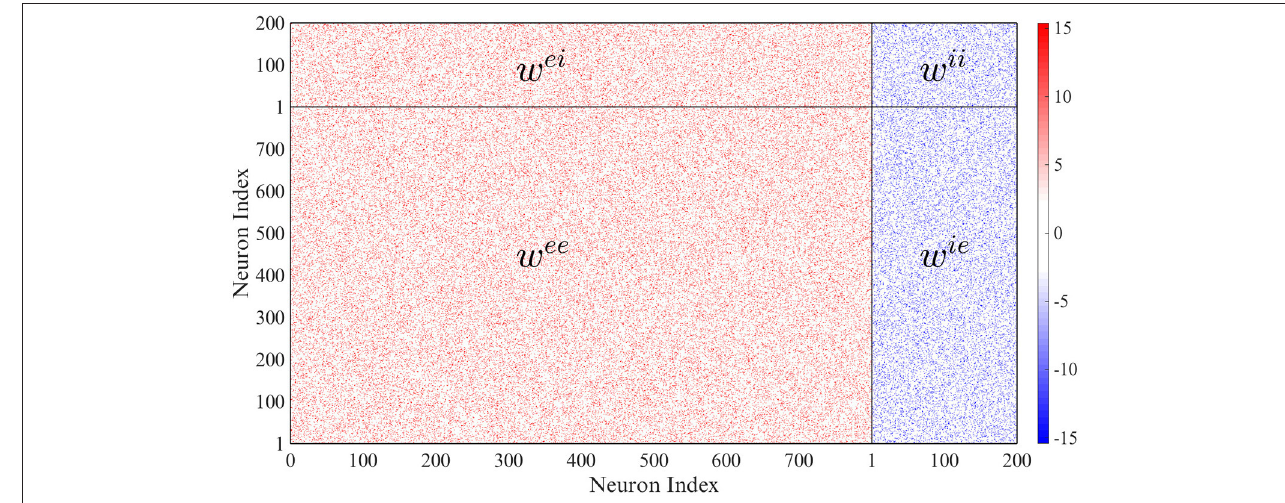
FIGURE 2 | Network connectivity. Only 10 percent of the weights are